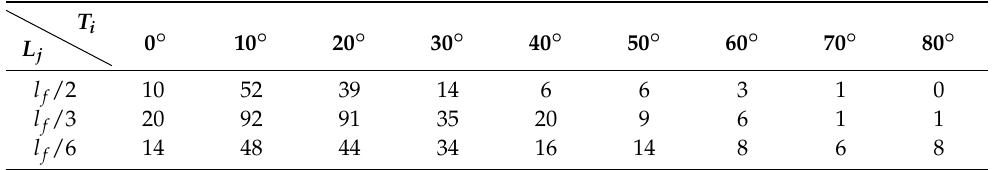
Table 3. Number of fibres in the ( θ , l e ) bins as obtained from the single-fibre segmentation of the µ CT image.